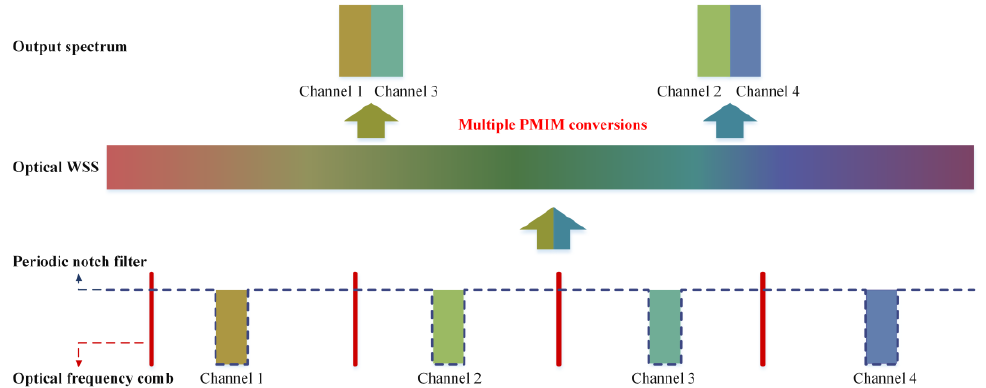
Figure 1. The proposed RF FSS schematic diagram based on multiple PMIM conversions. The RF signal containing multiple channels are modulated on the optical frequency comb and acted on by the periodic notch filter. Because the comb spacing of the optical frequency comb is slightly different from the FSR of the periodic notch filter, the RF components of different frequency will be suppressed in different optical channels. After the optical WSS, different optical channels will be merged, and under the PMIM conversion, different RF channels will also appear in the designed